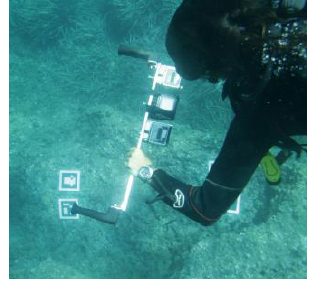
Figure 1. Second prototype of